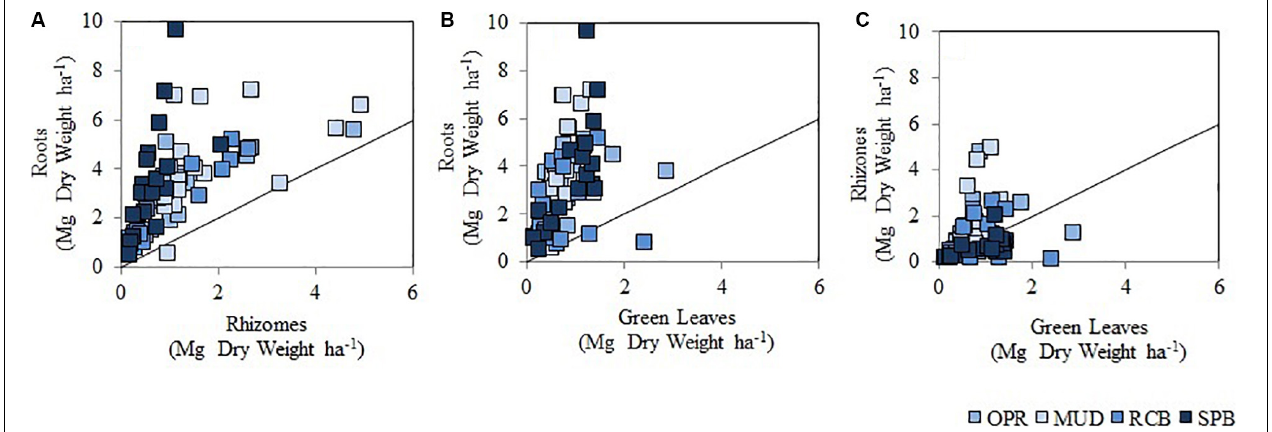
FIGURE 6 | Scatter plot showing living biomass in seagrass modules (all species pooled) in sampling sites. (A) It represents roots and rhizomes ratio (Ro:Rh), (B) it is roots and green leaves (Ro:Gl), (C) shows rhizomes and green leaves (Rh:Gl). Circles in colors respond to sampling sites and waves exposure levels as MUD (I), OPR (II), RCB (III), and SPB (III), from light blue to dark blue. There are 18 replicates per site, data from wet and dry season pooled. The black line indicates a 1:1 relation between the different seagrass modules.